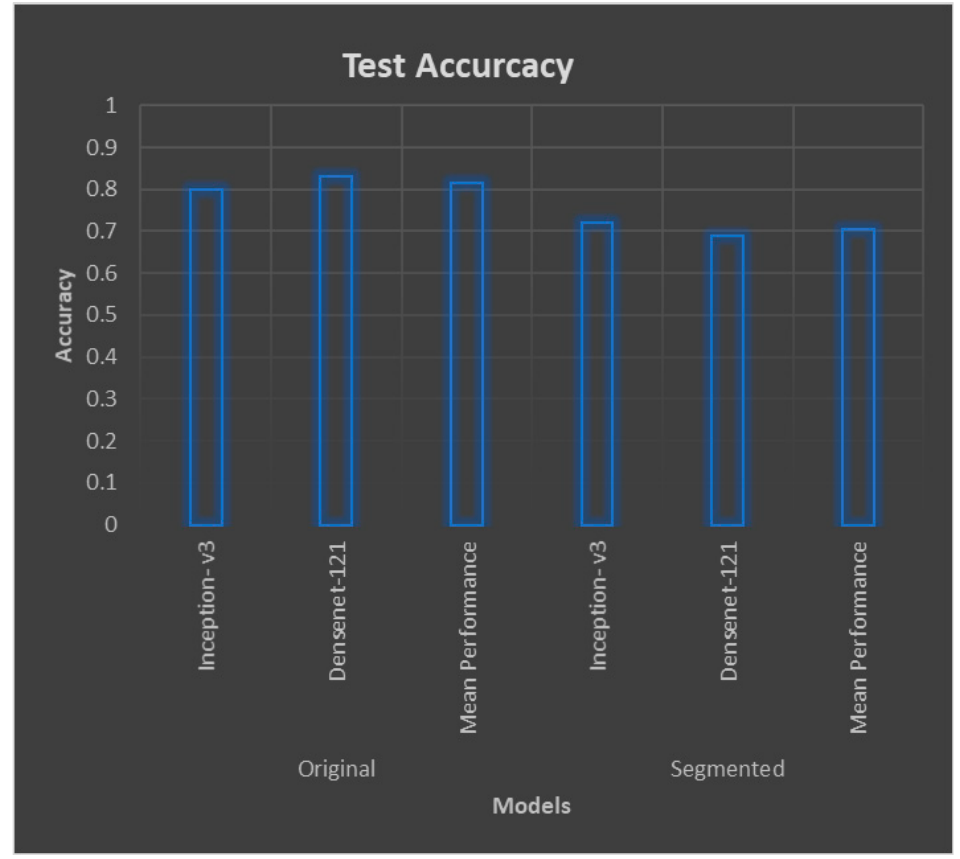
Figure 5. Mean test performances for original and segmented blood vessels.